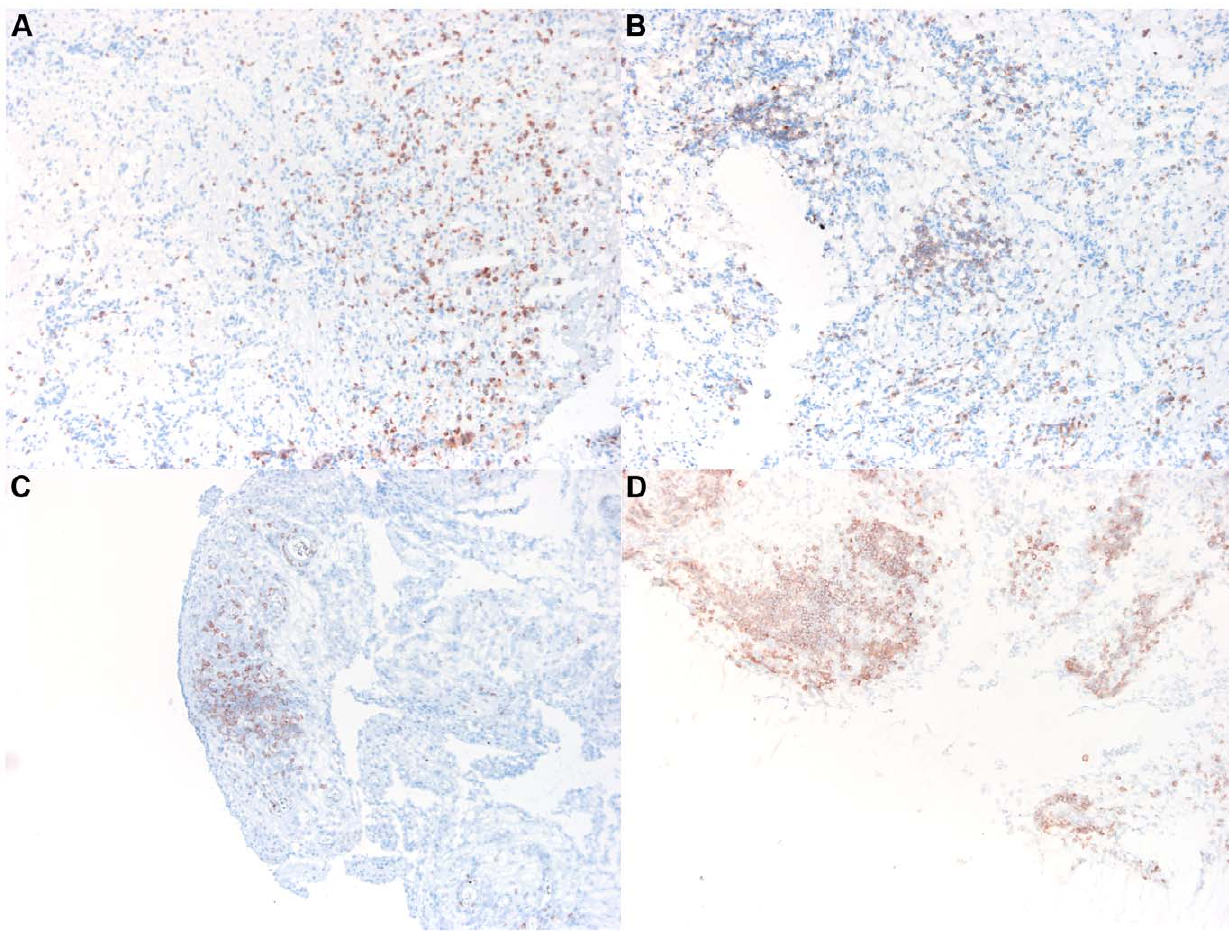
Figure 1. Lymphocyte aggregates. T he presence of lymphocyte aggregates was assessed on anti-CD3-stained sections. Aggregates were counted and graded by size. Aggregate size was assessed by counting the number of cells in a radius starting from an estimated center of the aggregate. Aggregate size was then classified as grade 1 (1–5 cells in the radius [panel B]), grade 2 (5–10 cells in the radius [panel C]), or grade 3 ( . 10 cells in the radius [panel D]). Tissue sections with no lymphocyte aggregates were graded as 0 (panel A).